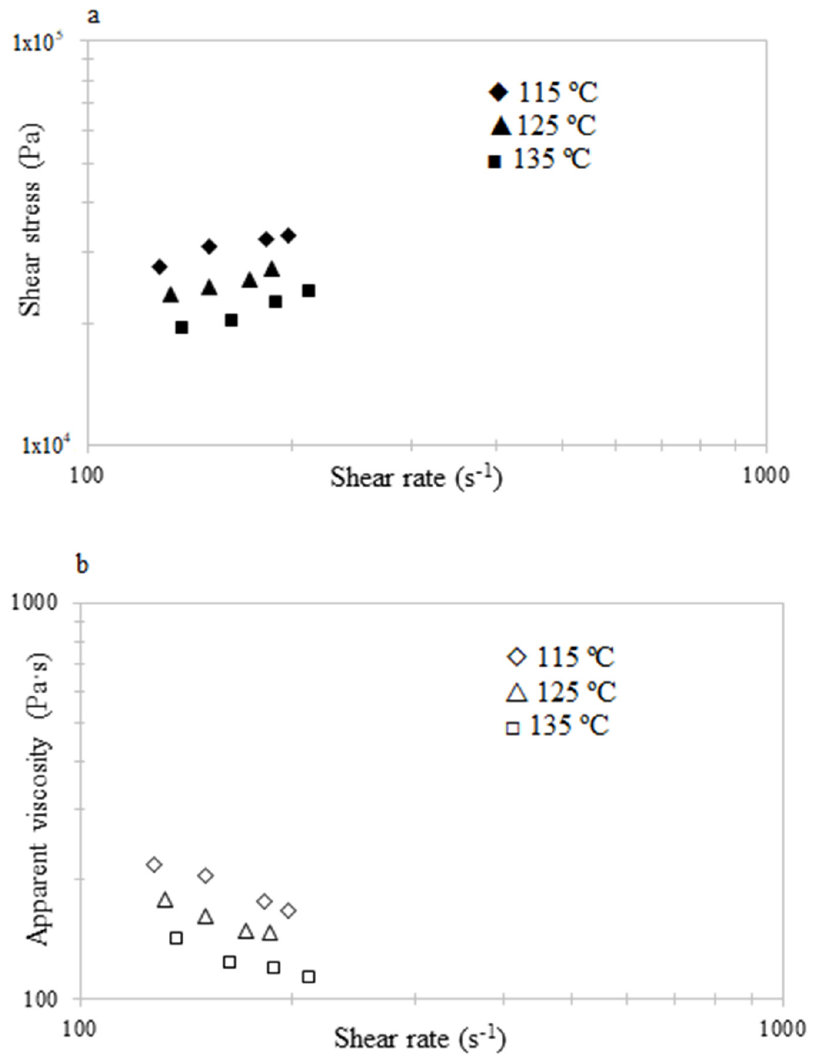
Figure 2. Effect of temperature variation on shear stress ( a ) and apparent viscosity ( b ) in the treatments studied with a moisture content of 22% and 35% HPF.